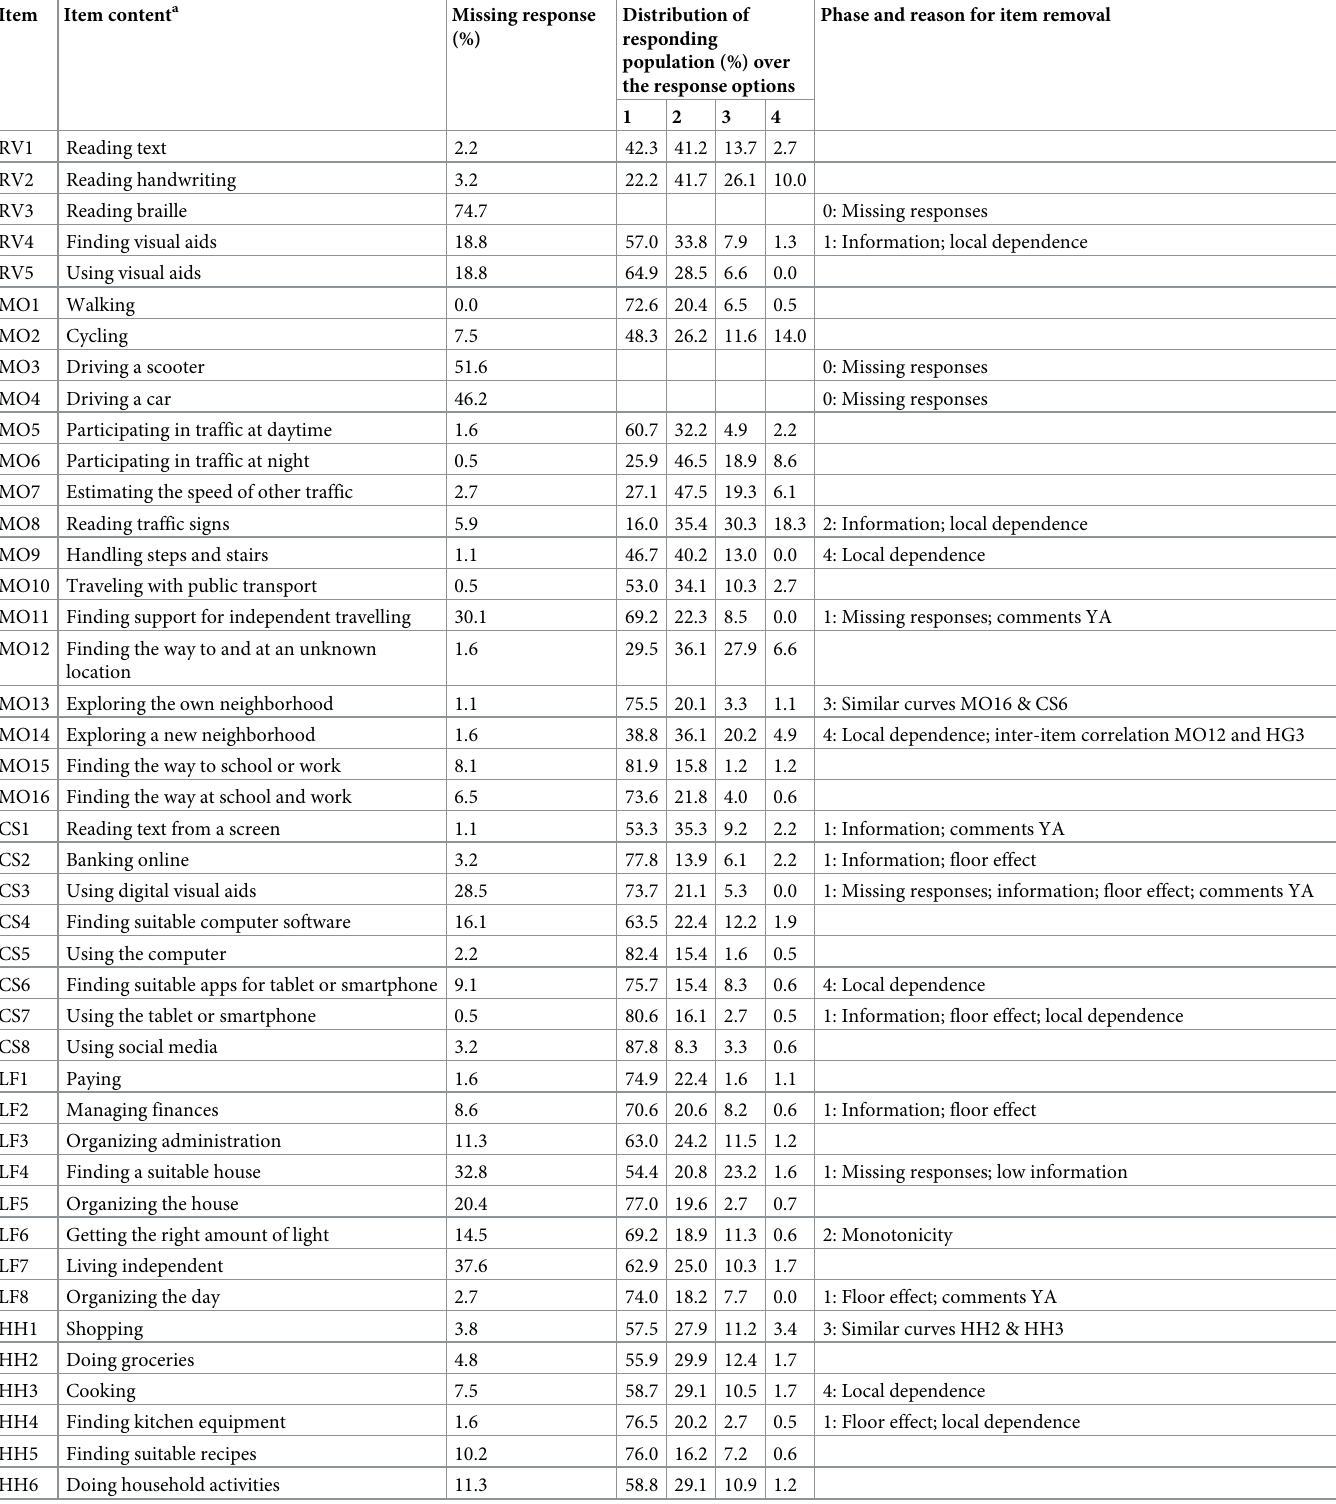
Table 2. Distribution of responses over the response options, and phase and reason for item